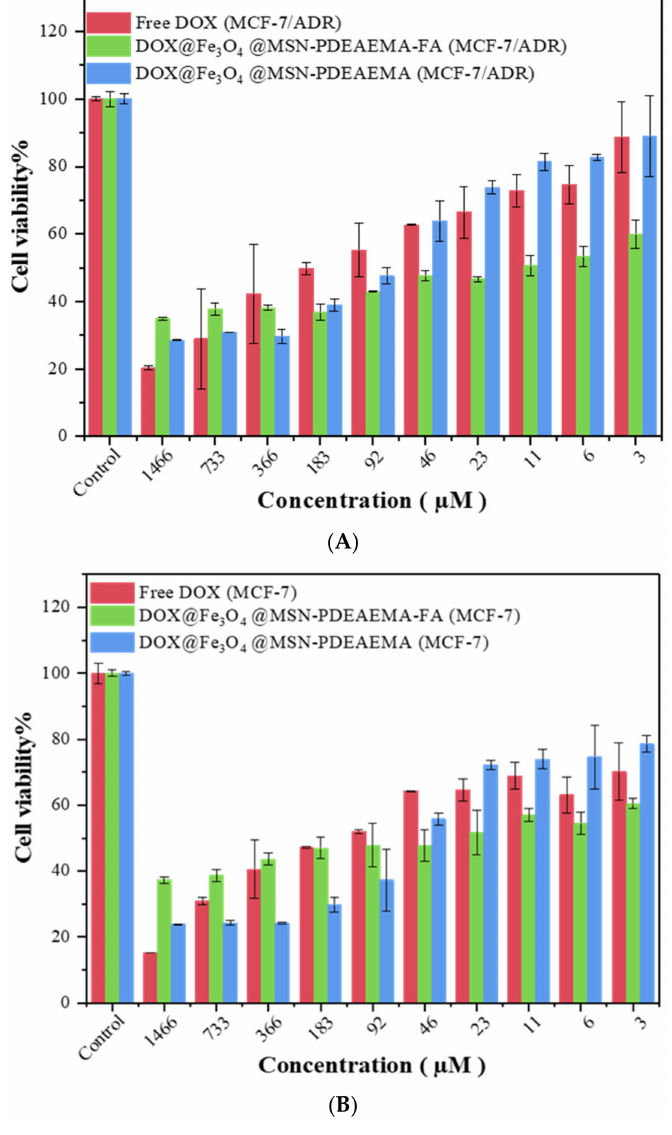
Figure 8. Cytotoxicity assay of the hybrid magnetic nanostructured. ( A ) Exposure of